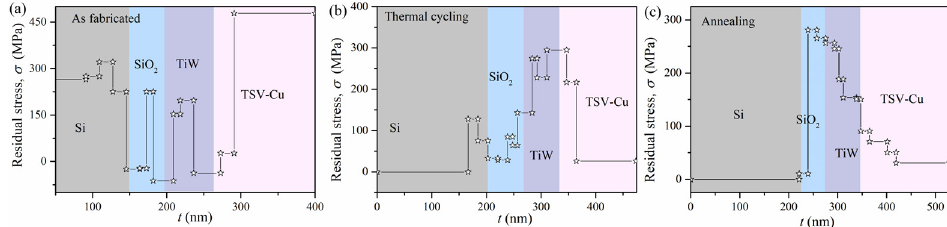
Figure 5. The residual stress distributions of each sublayer in the three samples under different thermal loading conditions: ( a ) as fabricated; ( b ) thermal cycling; ( c ) annealing.